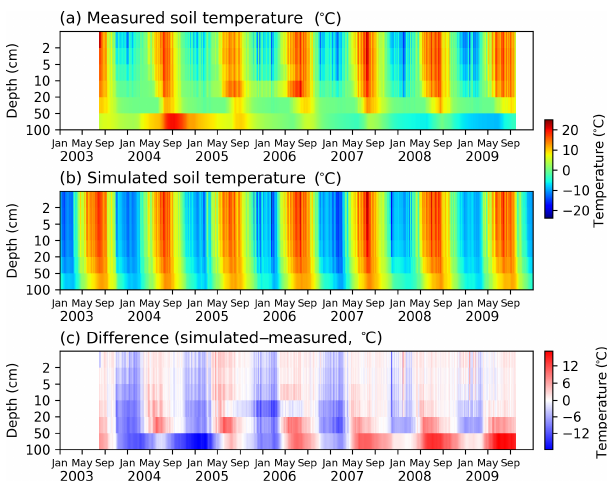
Figure 8. Measured (a) and simulated (b) soil temperature, and their difference (c) at the CA-Wp1 (54.95 ◦ N, 112.47 ◦ W) fen site. The measured soil temperature (a) is the mean of a hummock and a hollow. Soil temperature was measured at 2, 10, 20, 50, and 100cm below soil surface. To compare simulated soil temperatures with the measurements, we linearly interpolated simulated soil temperature in different layers to the depths of the